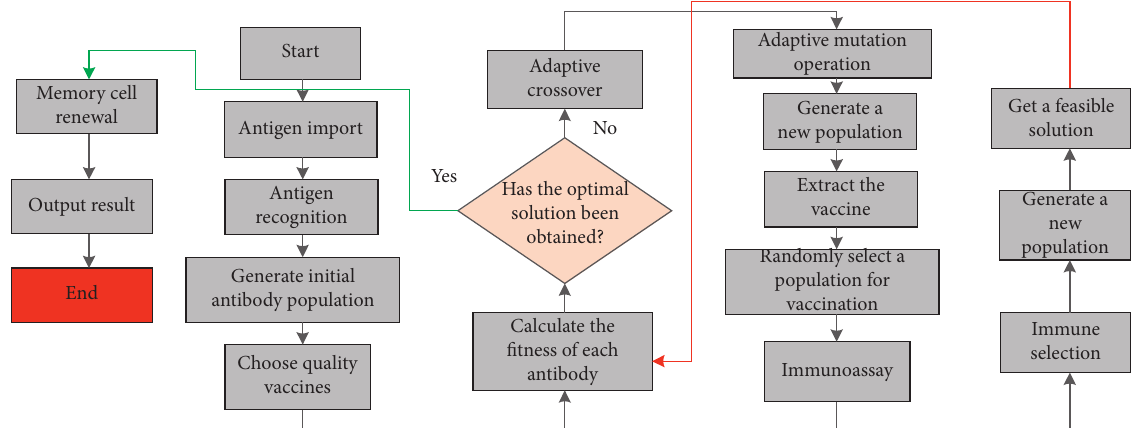
Figure 4: Predictive design process based on adaptive immune genetic